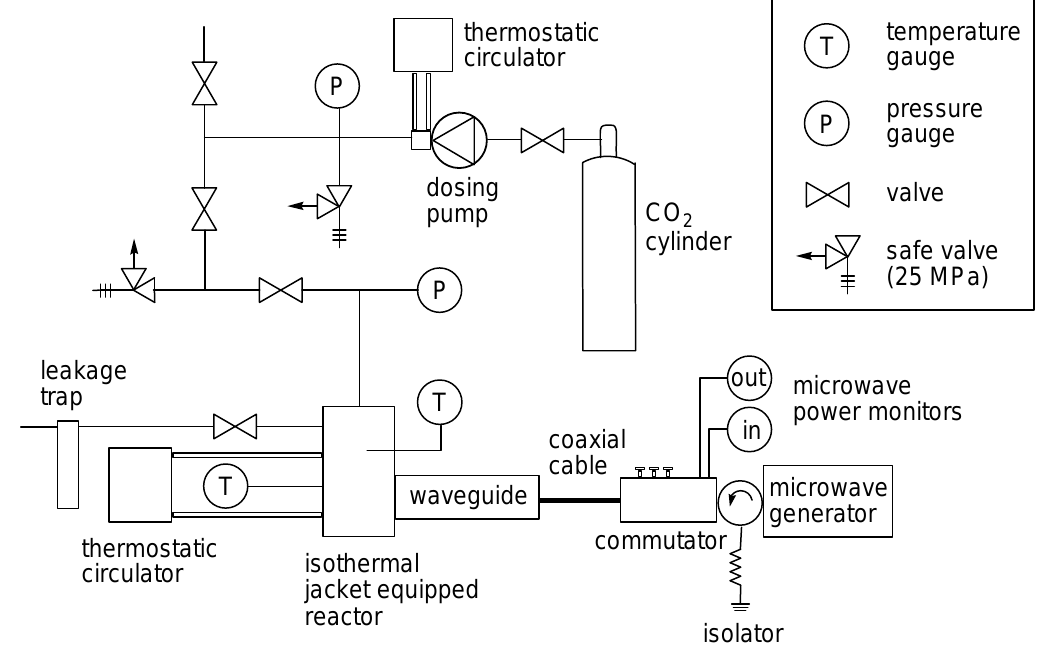
Figure 1. Schematic view of microwave-assisted scCO